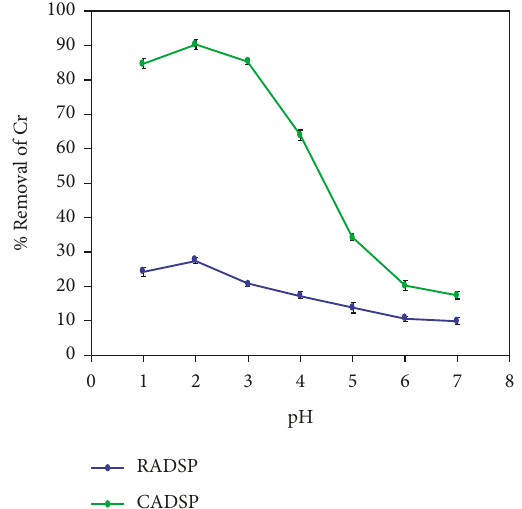
Figure 6: Influence of pH on Cr(VI) biosorption onto RADSP & CADSP.